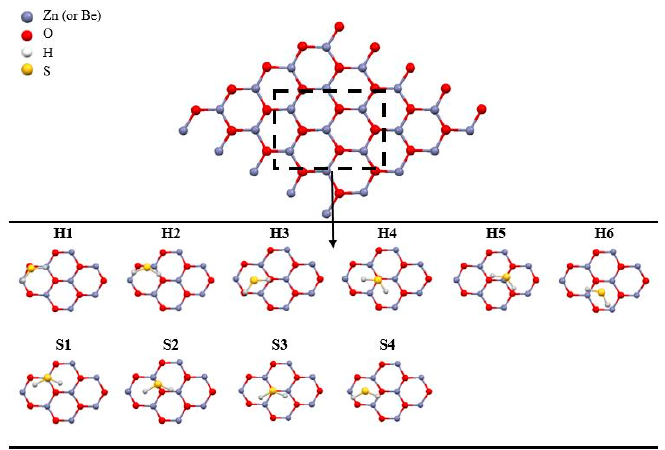
Figure 2. Schematic view of H 2 S interacting with ZnO (or BeO) nanosheet in ten various adsorption configurations. Table 1. Calculated adsorption energies of H 2 S on ZnO and BeO nanosheets at the different adsorption sites shown in Figure 2.